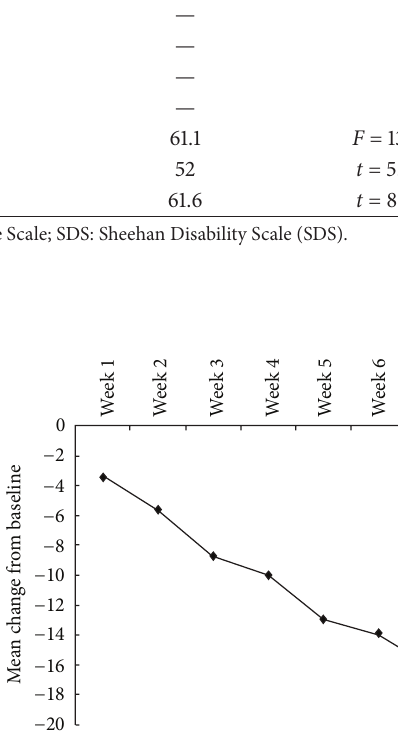
Figure 1: Symptom improvement in patients with TRD on